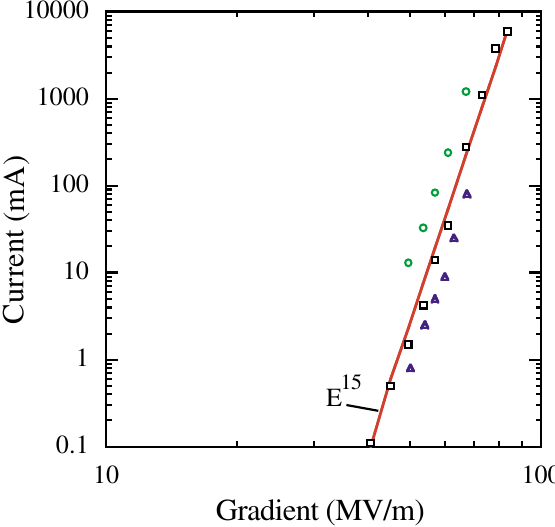
FIG. 30. (Color) Dark currents from an NLC prototype cavity.